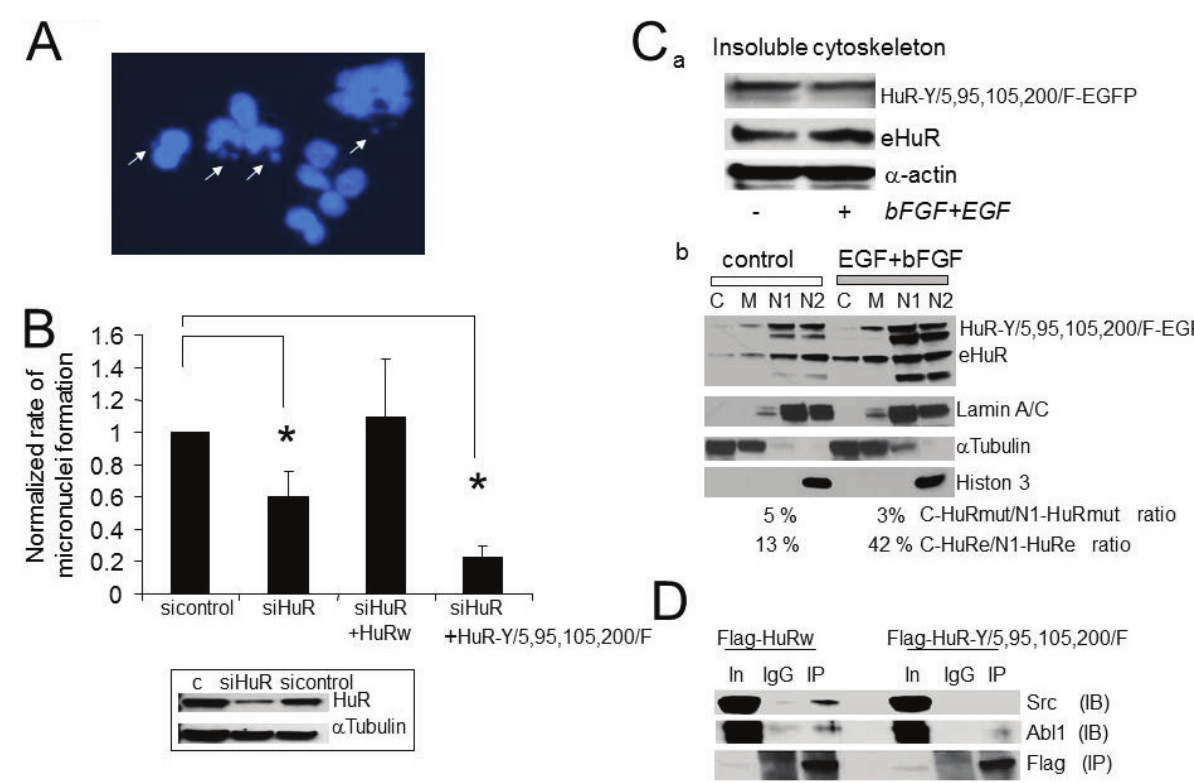
Figure 7. Increase in genomic instability is the consequence of growth factor dependent HuR phosphoregulation. ( A ) Illustration of micronuclei formation in U251 cells treated with growth factors. The micronuclei were detected with DAPI as isolated small DNA foci (marked with arrows). ( B ) The graph represents the averaged percentages of cells exhibiting micronuclei formation normalized to the value of micronuclei formation in sicontrol cells. The following conditions are shown: sicontrol, siHuR, siHuR plus HuRwild-EGFP, and siHuR plus HuR-Y/5, 95, 105, 200/F-EGFP. Note there is a significant decline in the percentages of cells with micronuclei in siHuR (0.60 ± 0.16, n = 3, p = 0.055) and siHuR plus HuR-Y/5,95,105,200/F-EGFP (0.23 ± 0.07, n = 3, p = 0.001) conditions compared to the sicontrol. All experiments were performed equally in the presence of growth factors (EGF, 40 nM and bFGF 40 nM, 48 h). The insert illustrates the decrease of endogenous HuR expression following transfection with siHuR RNA against 3'-UTR of HuR mRNA detected in Western blot. ( C ) The illustration of native HuR and HuR-Y/5,95,105,200/F-EGFP mutant proteins in insoluble cytoskeleton fractions before and after stimulation with growth factors detected in Western blot (a) and in soluble cytoplasmic, membrane, soluble nuclear, insoluble nuclear fractions (b). The fractions are marked as C-cytoplasmic, M-membrane, N1-soluble nuclear, N2-insoluble nuclear. ( D ) Illustration of co-immuno-precipitation of Src and Abl1 kinases with Flag-HuR and Flag-HuRmut proteins. The Flag-HuR and Flag-HuRmut proteins were immuno-precipitated by using Flag antibodies. The lines are marked as In—input (4%), IgG-immuno-precipitation with mouse IgG antibody, IP—immuno-precipitation with Flag antibody. The experiment has been performed in the presence of growth